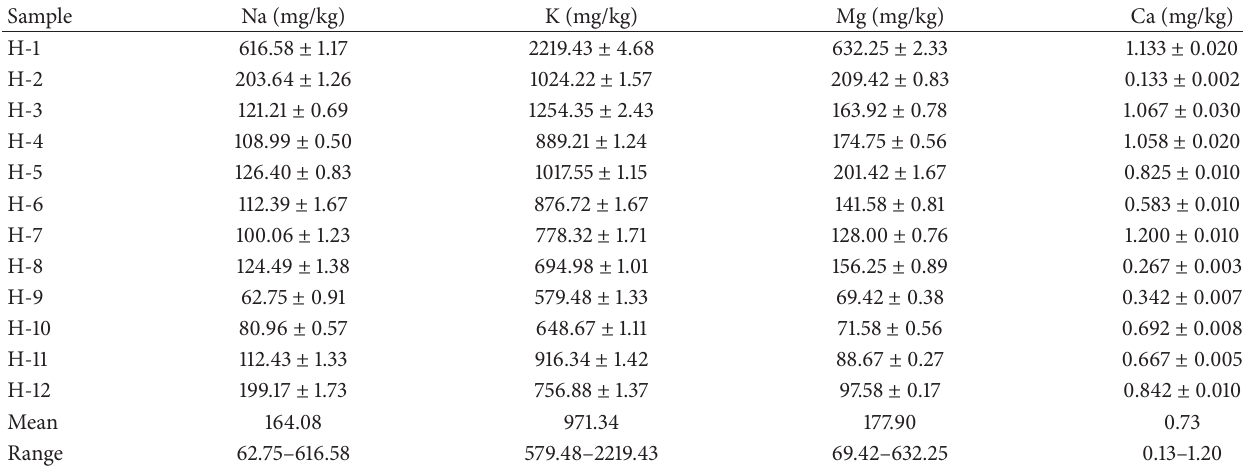
Table 3: Mineral content of the honey samples from